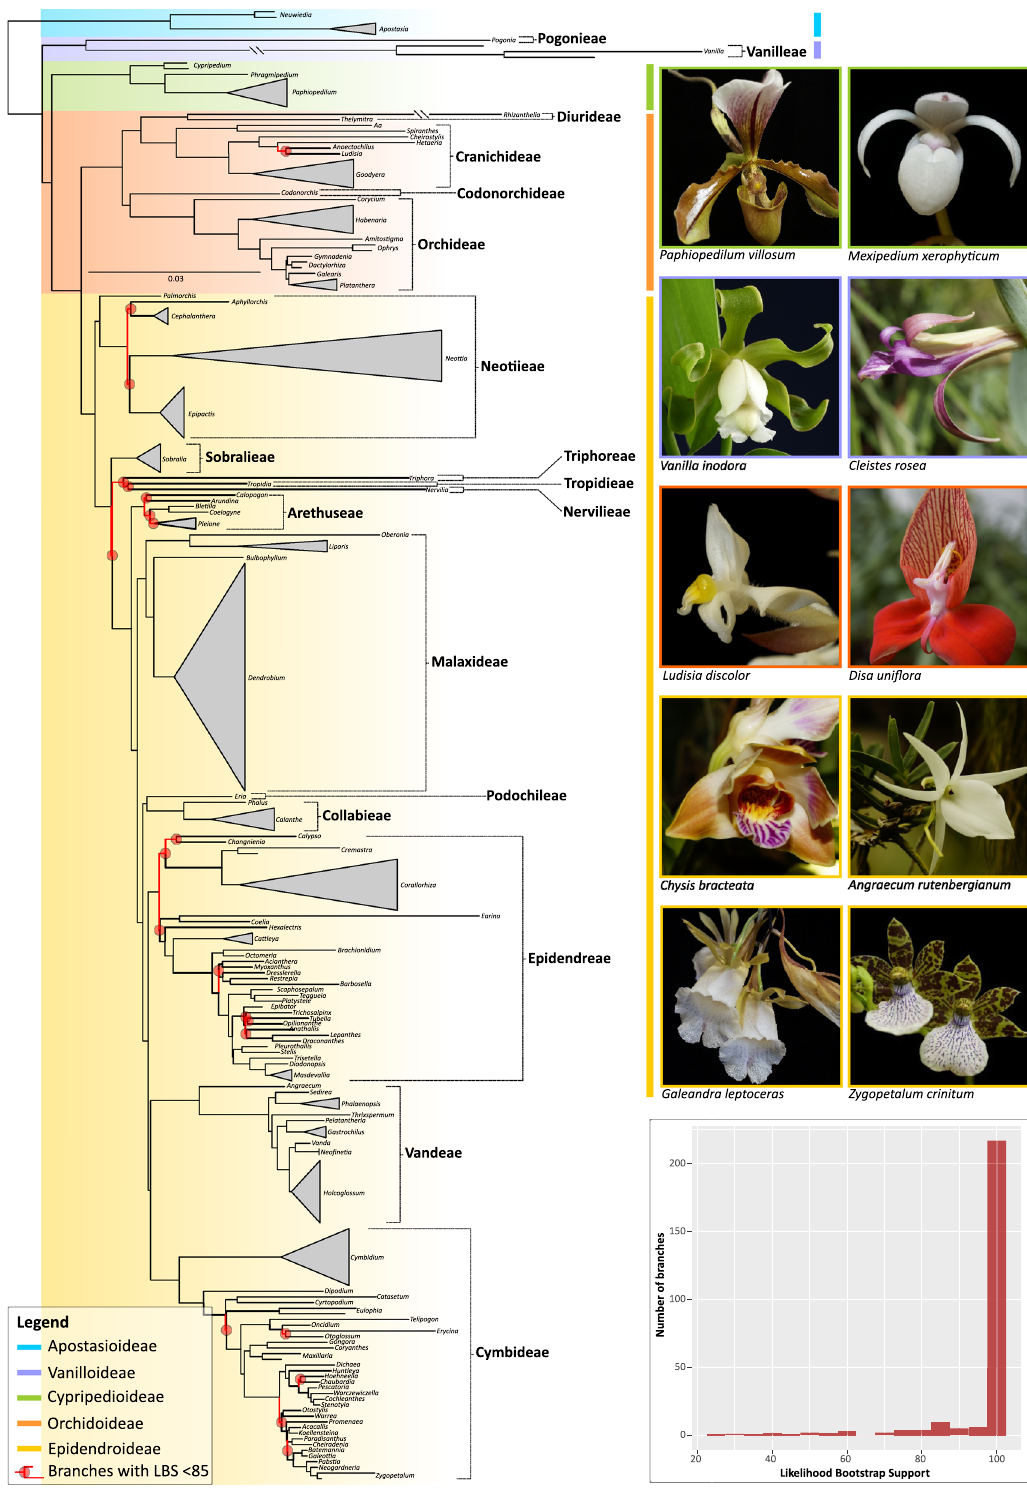
Figure 1. Maximum Likelihood phylogeny of the orchid family inferred from 78 coding plastid genes. Likelihood bootstrap support values (LBS) < 85% at nodes are highlighted in red together with their corresponding subtending branches. Orchid genera, tribes and subfamilies are indicated in the phylogeny together with photographs of selected representative species per subfamily. (Inset): Bar plot showing the frequency of LBS values at branches as computed by bin intervals of 5 units. Photos: O. Pérez-Escobar & D.